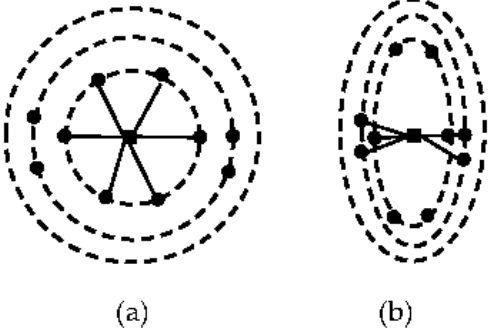
Figure 5. Different selections of proximity points in the cases of isotropic and anisotropic assumptions. ( a ) Spatial neighbor point selected in the homogeneous space; ( b ) spatial neighbor point selected when considering anisotropy.